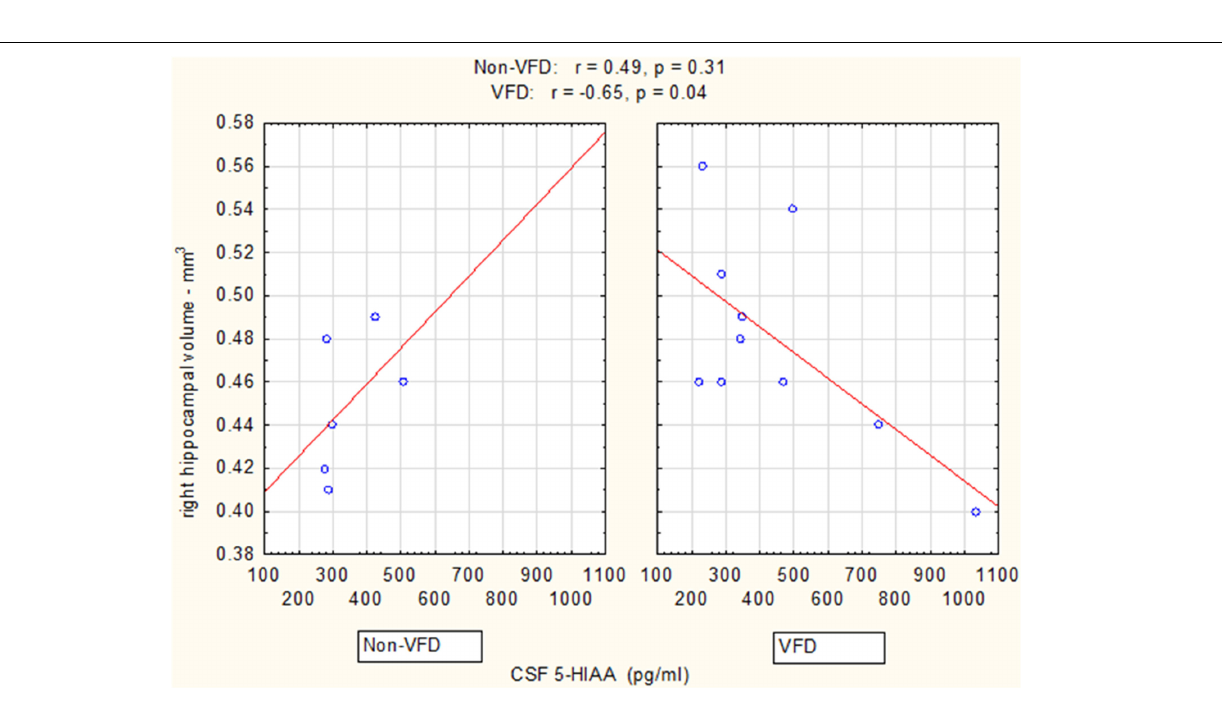
non-VFD subjects [right hippocampal × rearing condition interaction: F (1 , 12) = 3 . 29, p = 0 . 095]. See Pearson’s correlations at the top of the figure.